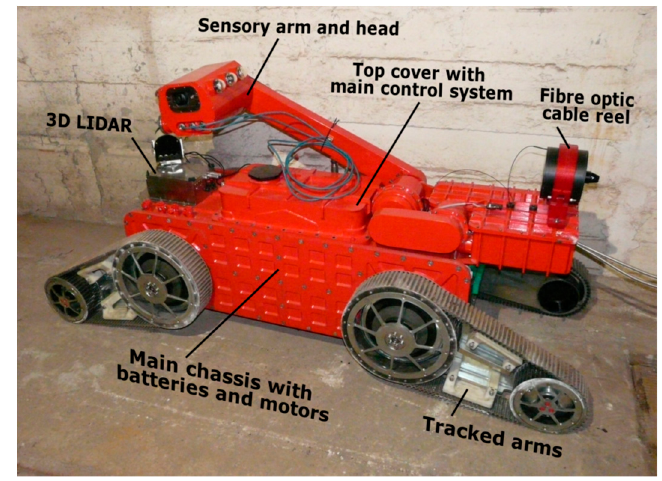
Figure 4. TeleRescuer—main subsystems.